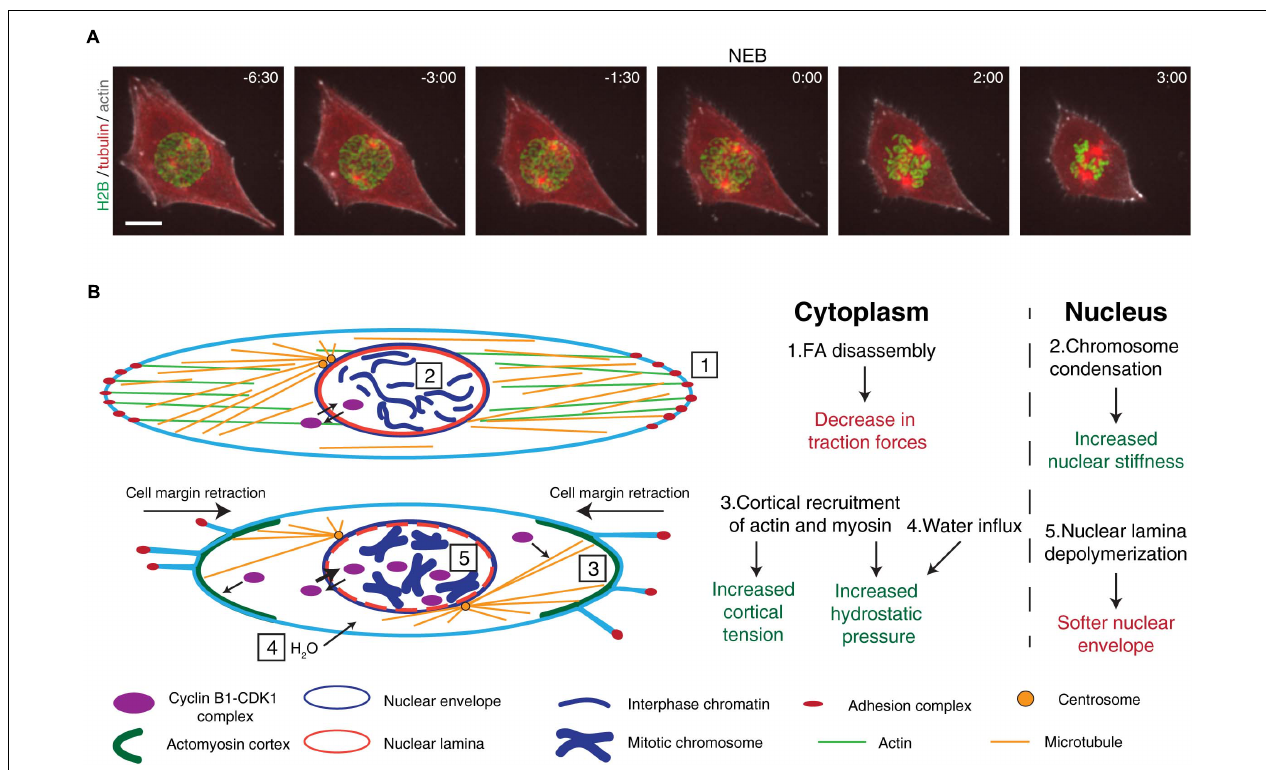
FIGURE 1 | Overview of the cytoskeletal and nuclear reorganization that occur during mitotic entry. (A) Representative frames from a movie of a RPE-1 cell expressing H2B-GFP/tubulin-RFP/SiR-actin during mitotic entry. It is possible to observe the main events that occur during mitotic entry, such as cell rounding, chromosome condensation, and centrosome separation. After NEB, mitotic rounding continues as the spindle assembles. Time is in min:sec. Scale bar, 10 µ m. Time zero corresponds to NEB. (B) Main events that occur during the G2-M transition. Cyclin B1-CDK1 complexes shuttle between the cytoplasm and the nucleus. At this stage, the cell is attached to the extracellular matrix through membrane-bound adhesion complexes (1) and the microtubule and actin cytoskeletons are in their interphase configuration. Inside the nucleus, chromatin is decondensed and the nuclear envelope and nuclear lamina are intact (2). As cells prepare to enter mitosis, adhesion complexes disassemble, leading to cell membrane retraction and mitotic cortex assembly (3). Together with osmotic swelling (4), this leads to increased intracellular pressure. At the same time, active cyclin B1-CDK1 complexes accumulate in the nucleus, triggering chromosome condensation, nuclear lamina depolymerization (5), and nuclear envelope permeabilization. These events trigger changes global changes in the forces during the G2-M